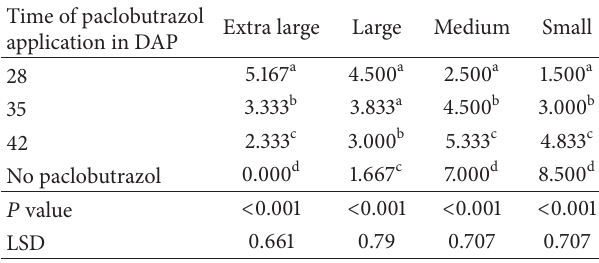
Table 4: Effect of time of paclobutrazol application on potato tuber grades as per plant.